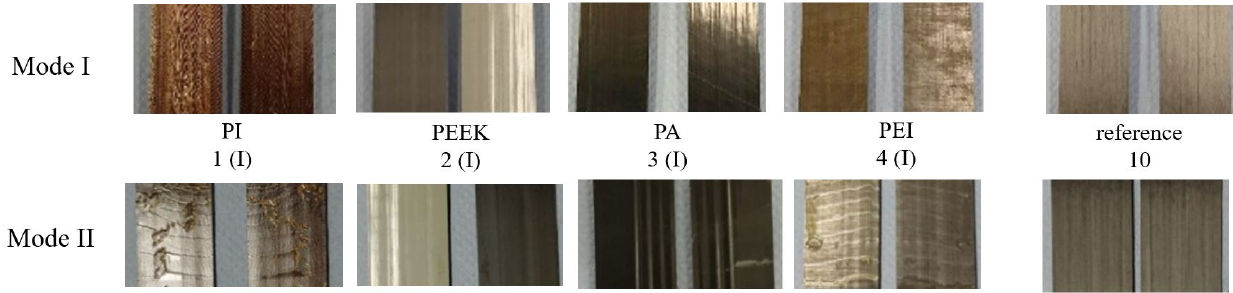
Figure 7. Representative fracture surfaces resulting from Mode I (DCB) and Mode II (ELS) testing for embedding configura- tion I and reference configuration.